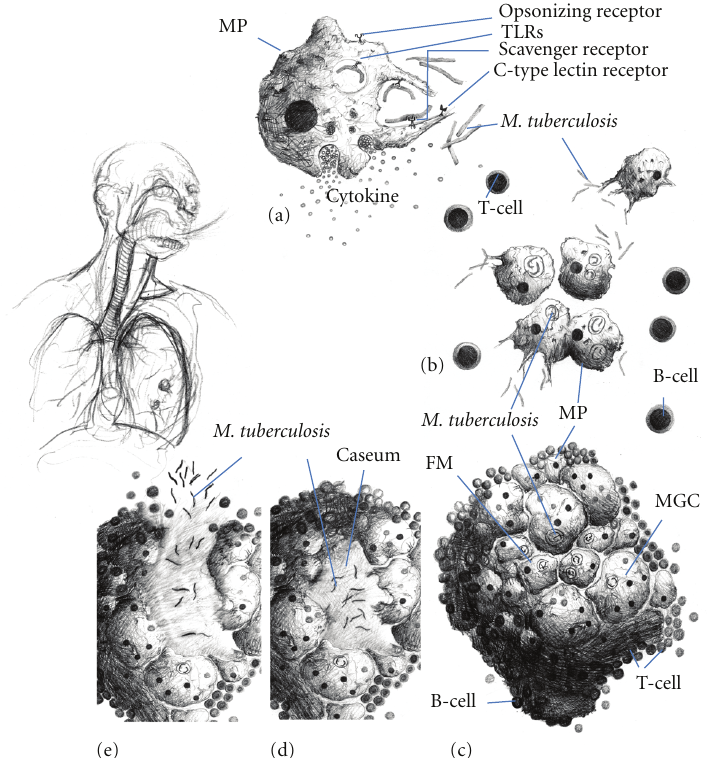
Figure 1: Formation and maturation of lung tuberculous granulomas. Following inhalation of contaminated aerosols, M . Tuberculosis moves to the lower respiratory tract where it is recognized by alveolar macrophages. This recognition is mediated by a set of surface receptors (see text), which drive the uptake of the bacteria and trigger innate immune signalling pathways leading to the production of various chemokines and cytokines (a). Epithelial cells and neutrophils can also produce chemokines in response to bacterial products (not represented). This promotes recruitment of other immune cells (more macrophages, dendritic cells, and lymphocytes) to the infection site (b). They organise in a spherical structure with infected macrophages in the middle surrounded by various categories of lymphocytes (mainly CD4 + , CD8 + , and γ / δ T cells). Macrophages (MP) can fuse to form MGCs or di ff erentiate into lipid-rich foamy cells (FM). B lymphocytes tend to aggregate in follicular-type structures adjacent to the granuloma ((c), see text for details). The bacteria can survive for decades inside the granuloma in a latent state. Due to some environmental (e.g., HIV infection, malnutrition etc.) or genetic factors, the bacteria will reactivate and provoke the death of the infected macrophages. A necrotic zone (called caseum due to its milky appearance) will develop in the centre of the granuloma (d). Ultimately the structure will disintegrate allowing exit of the bacteria, which will spread in other parts of the lungs and more lesions will be formed. Infection will also be transmitted to other individuals due to release of the infected droplets by coughing